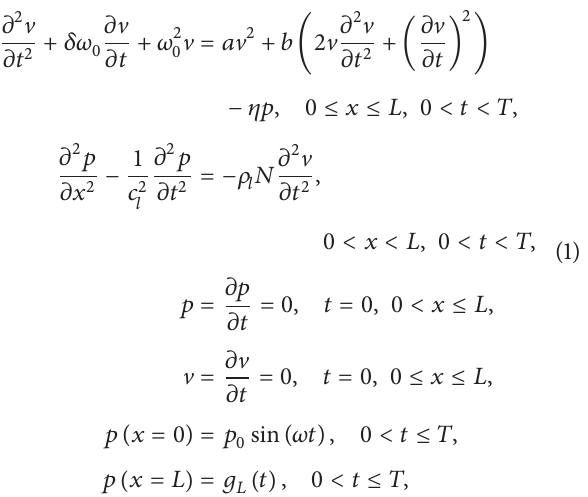
Table 1: Values of sound speed, attenuation coefficient, and com- pressibility coefficient of FC-43 liquid with helium gas bubbles (bold font values), of FC-43 liquid with air bubbles, and of water with air bubbles. Driving frequency is 𝑓 𝑟 = 20 kHz, bubble radius is = 7𝜇 m, and bubble density in the liquid is 𝑁 𝑅 0𝑟